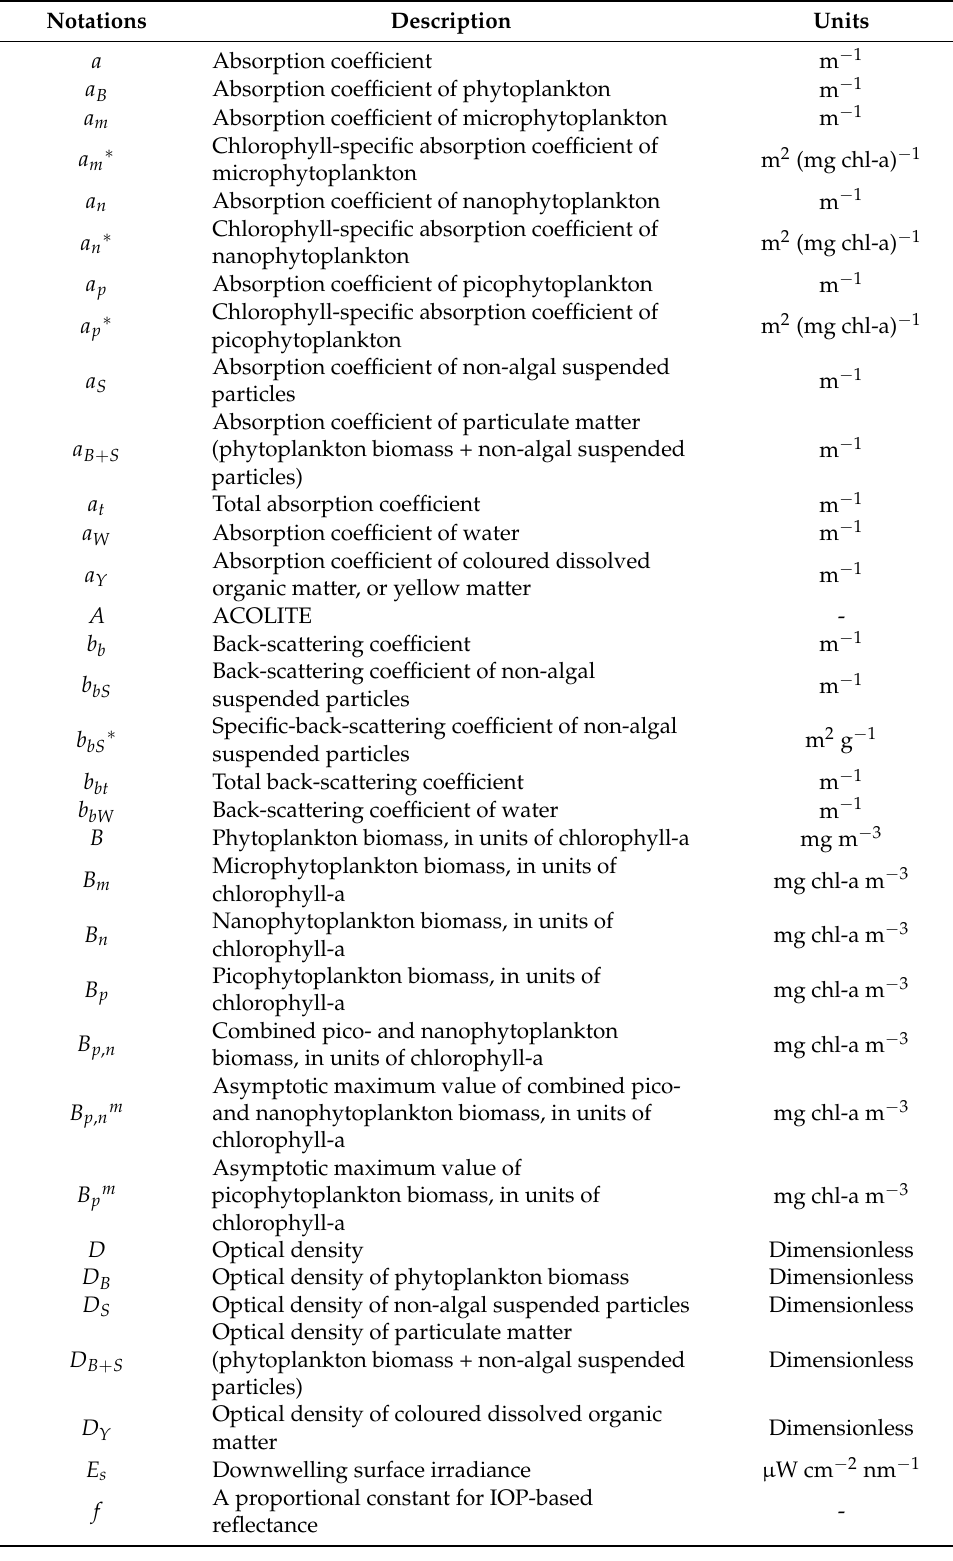
Table A1. Notations, their descriptions, and units used in the present